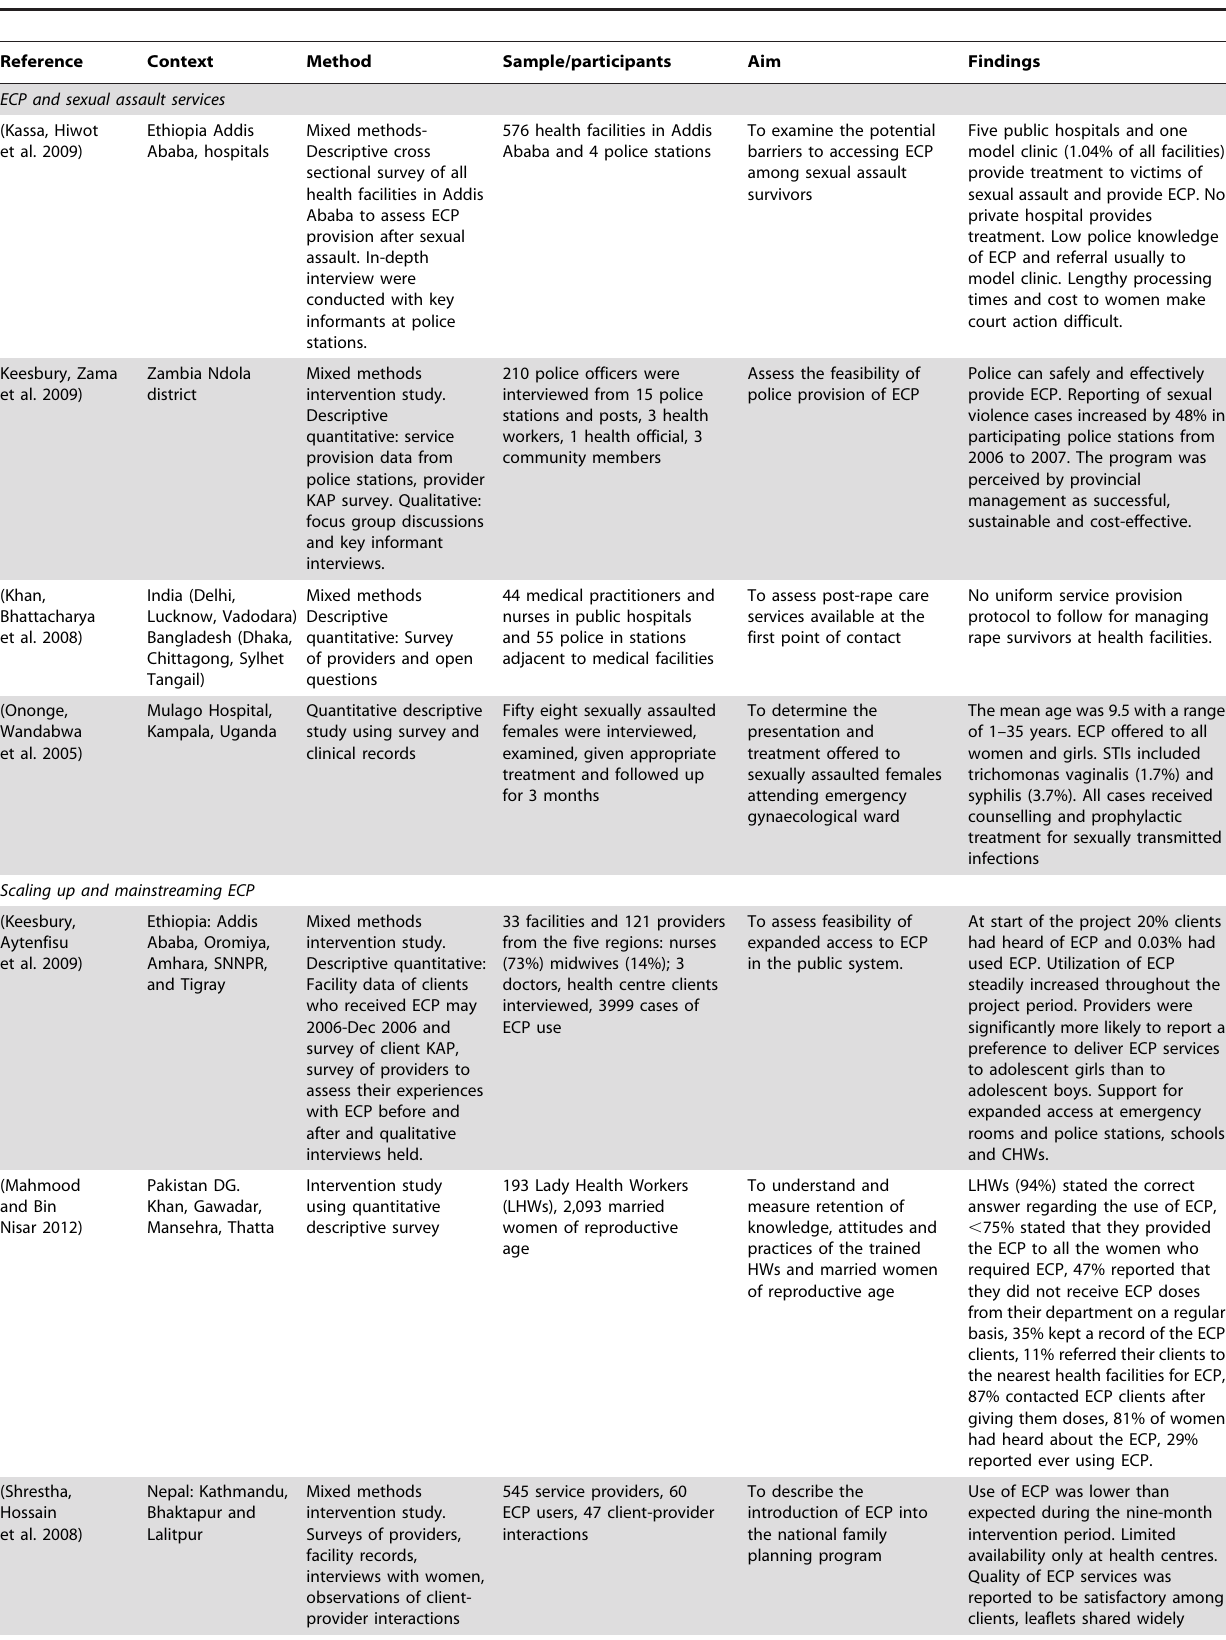
Table 2. Summary of studies included in the